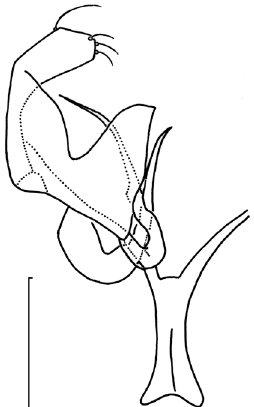
Figure 128. Hesperolyra diskusi , paratype, slide EvN4501, detail of left valva and lyre-shaped transtilla. Scale: 100